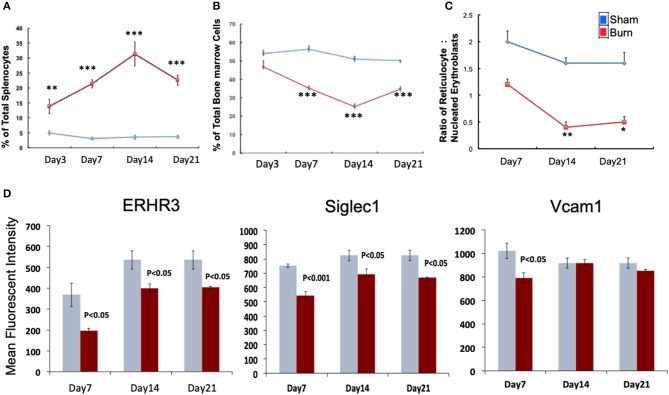
Burn injury perturbs myelopoiesis in bone marrow and spleen. (A,B) Line graphs represent CD71+Ter119± cells as percentage of total spleen (A) and total bone marrow cells (B) in sham (blue) and burn injury (red) after 3, 7, 14, and 21 days. (C) Maturation index (MI) calculated as the ratio of reticulocytes to nucleated BM erythroblasts (represented as y-axis of the line graph) at post burn days 7, 14, and 21 (x-axis), showing a significant decrease in MI throughout the course of burn injury. (D) Mean fluorescent intensities of adhesion molecules ERHR3, Siglec1, and Vcam1 in F4/80+ MØs after 7, 14, and 21 days of burn injury are depicted as bar graphs (sham = blue/gray, burn = red). Reduced expression of the three adhesion molecules is seen at post burn day 7. Error bars indicate standard error of mean of >3 independent experiments. *P < 0.05, **P < 0.001; ***P < 0.0001 vs. burn by one-way ANOVA.